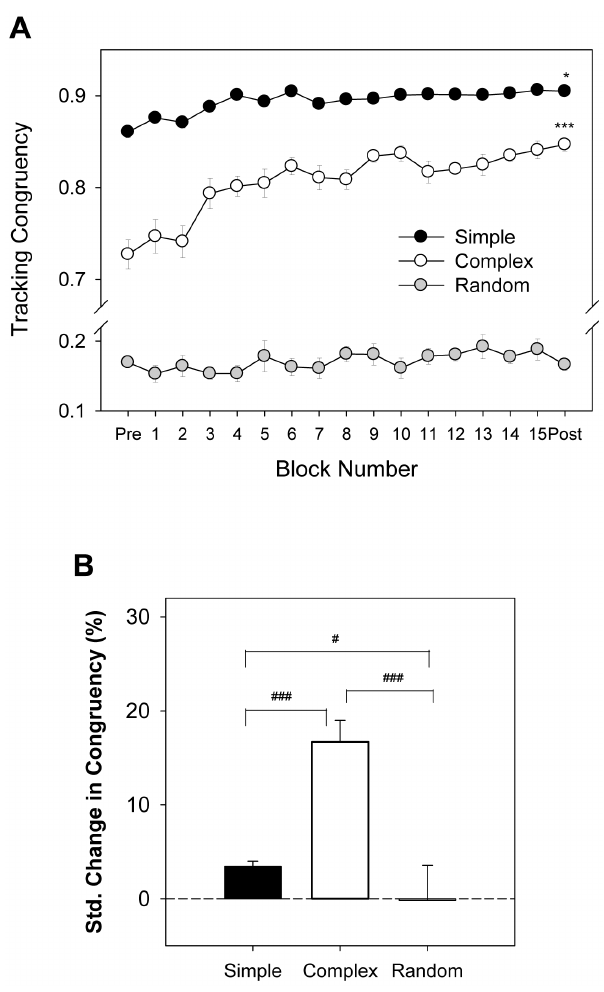
Figure 3. Contrast of mean evolutional changes in tracking performance among three practice protocols . (A) Tracking congruency, (B) Standardized change in tracking congruency due to practice effect among three practice protocols. ( * : post-test . pre-test, p , 0.05; *** : post-test . pre-test, p , 0.001)( # : significant difference between protocols, p , 0.0167; ### : significant difference between protocols, p ,